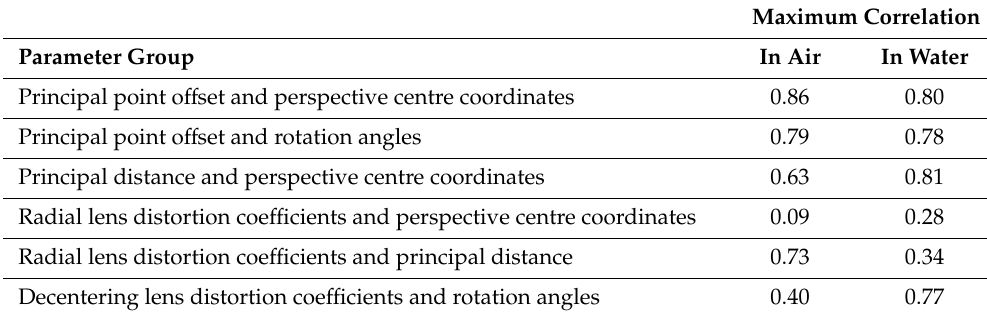
Table 4. Summary of the maximum correlation coe ffi cients (in absolute values) from the 12 in-air and 12 underwater independent self-calibration